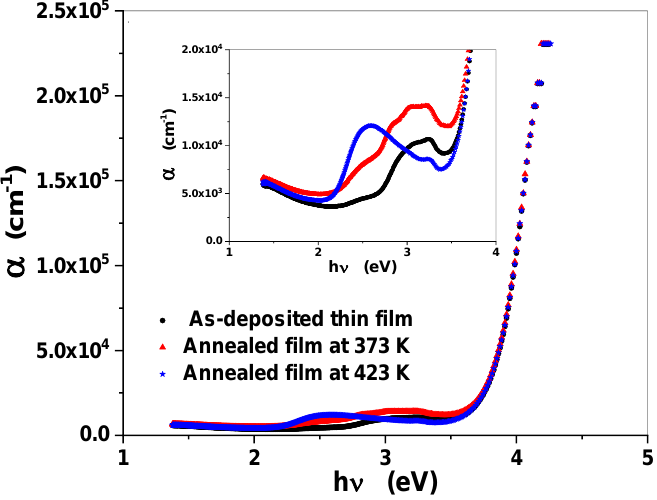
Figure 13. Plot of 𝛼 versus photon energy for compound 4 thin films. The optical band transitions of compound 4 thin films were estimated by using the relation for indirect optical transitions [48,51]: